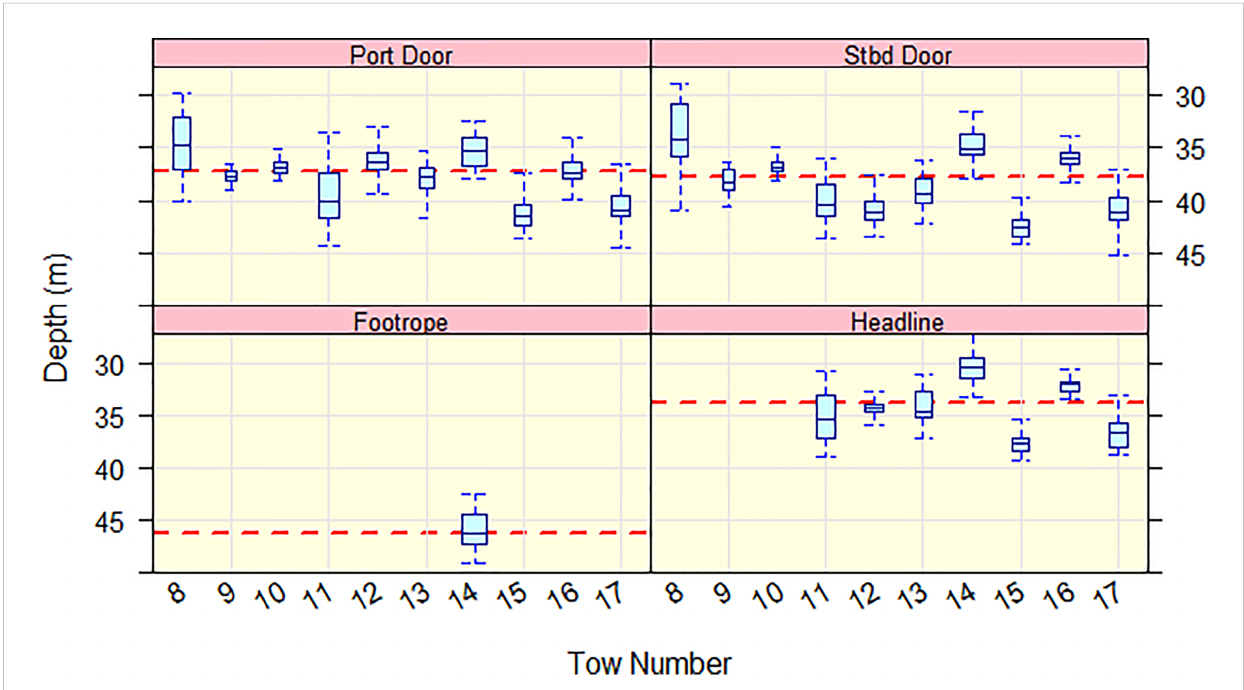
FIGURE 6 Door, footrope, and headline depths (y-axis) from trip 1 using RBR loggers for OBT tows (x-axis). Panels show individual sensor values with outliers removed for scaling. Dashed red lines are the panel medians. Box widths represent the sample sizes within